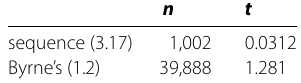
Table 2 (cid:2) = 10 –10 , P = 5, M = 3, N =